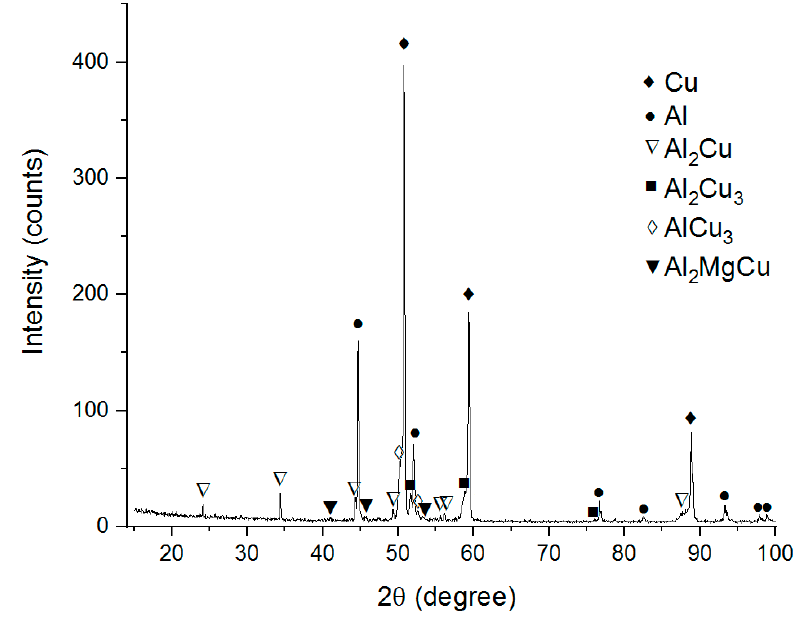
Figure 3. The XRD pattern of the Cu-Al stirring zone metal.